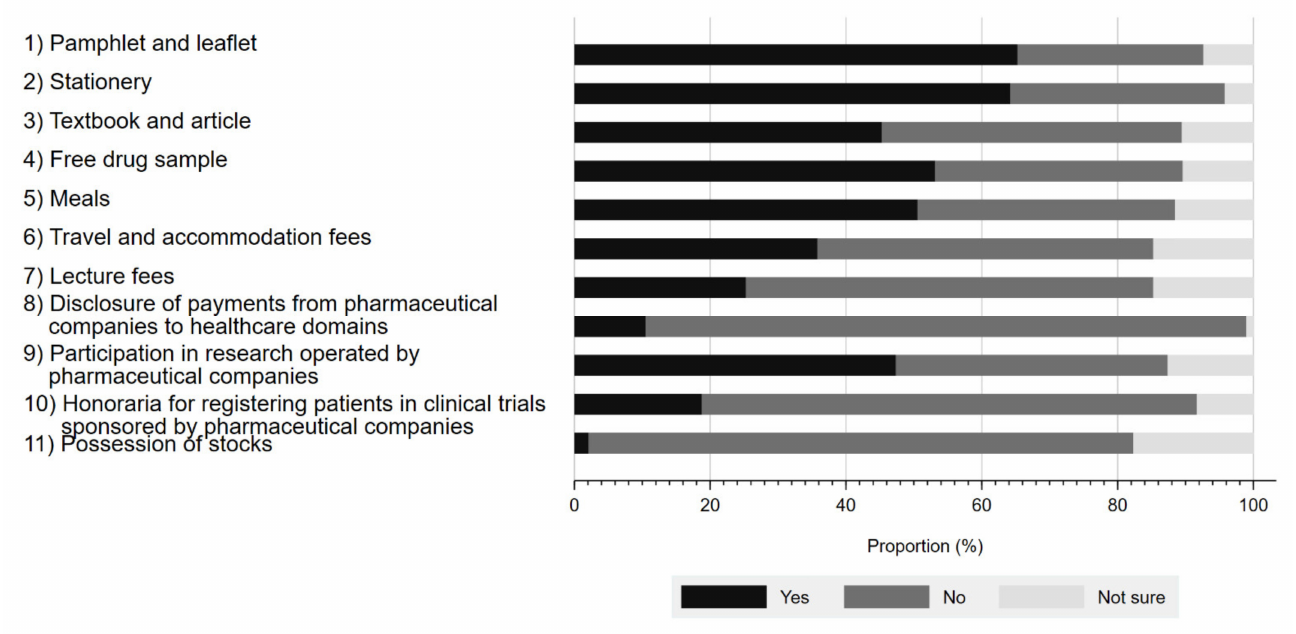
Figure 1. Respondents’ awareness of interactions between physicians and pharmaceutical